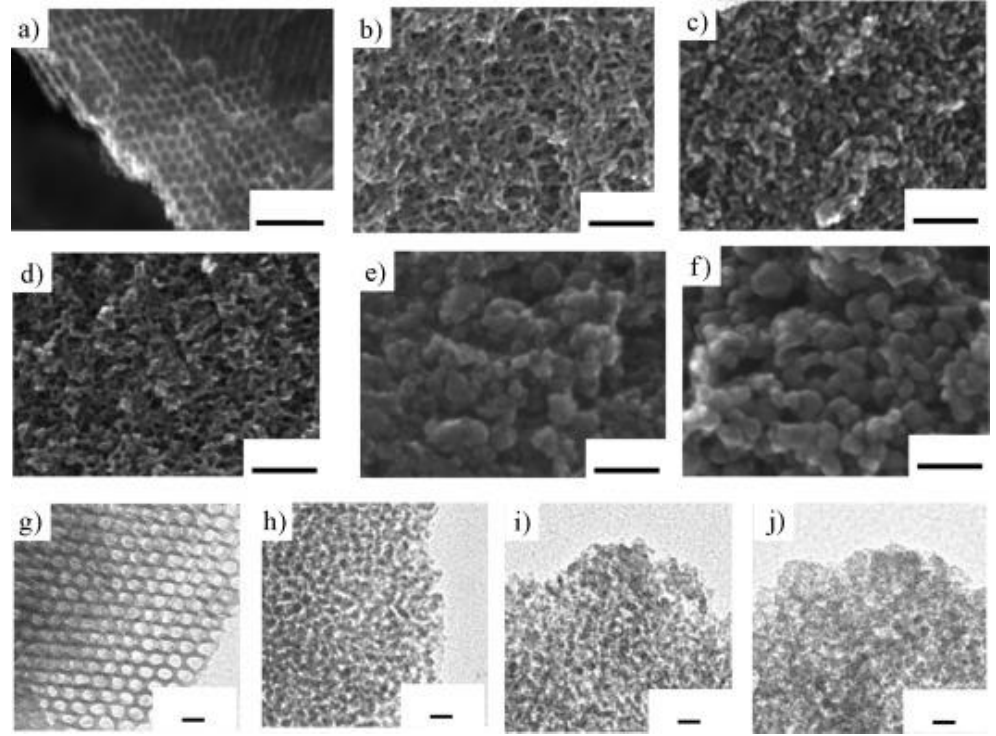
Figure 12. SEM images of mesoporous ( a ) Nb, ( b ) Nb 7 W 3 , ( c ) Nb 5 W 5 and ( d ) Nb 3 W 7 oxides (scale bar: 50 nm). SEM images of non-mesoporous ( e ) Nb 1 W 9 and ( f ) W oxides (scale bar: 50 nm). TEM images of mesoporous ( g ) Nb, ( h ) Nb 7 W 3 , ( i ) Nb 5 W 5 and ( j ) Nb 3 W 7 oxides (scale bar: 10 nm). Reproduced